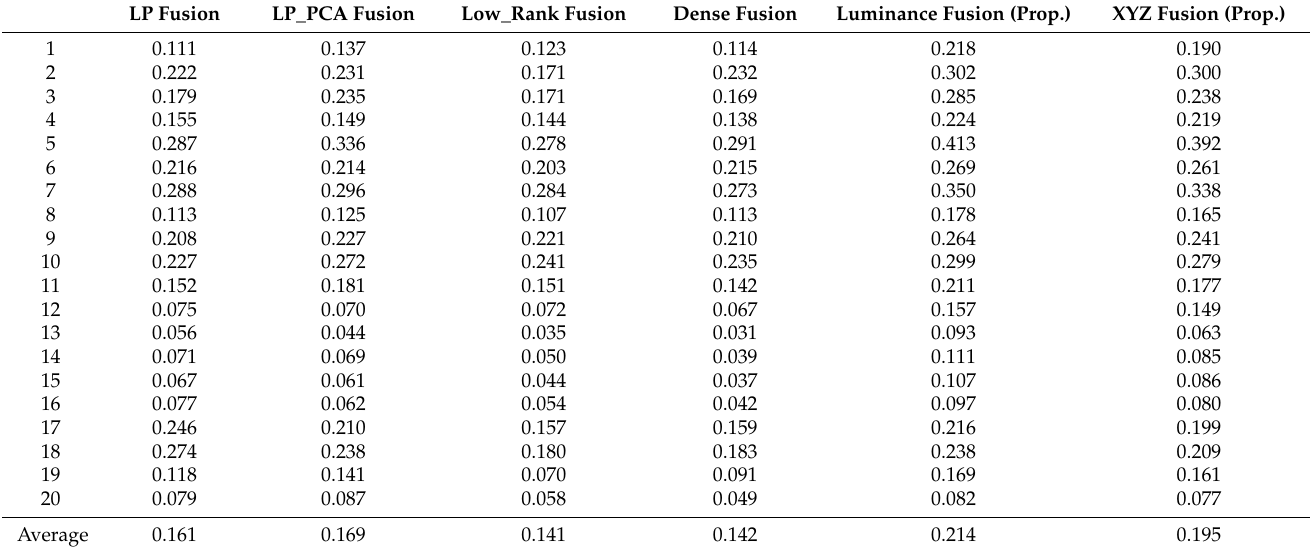
Table 8. Comparison of the S3 sharpness metrics.